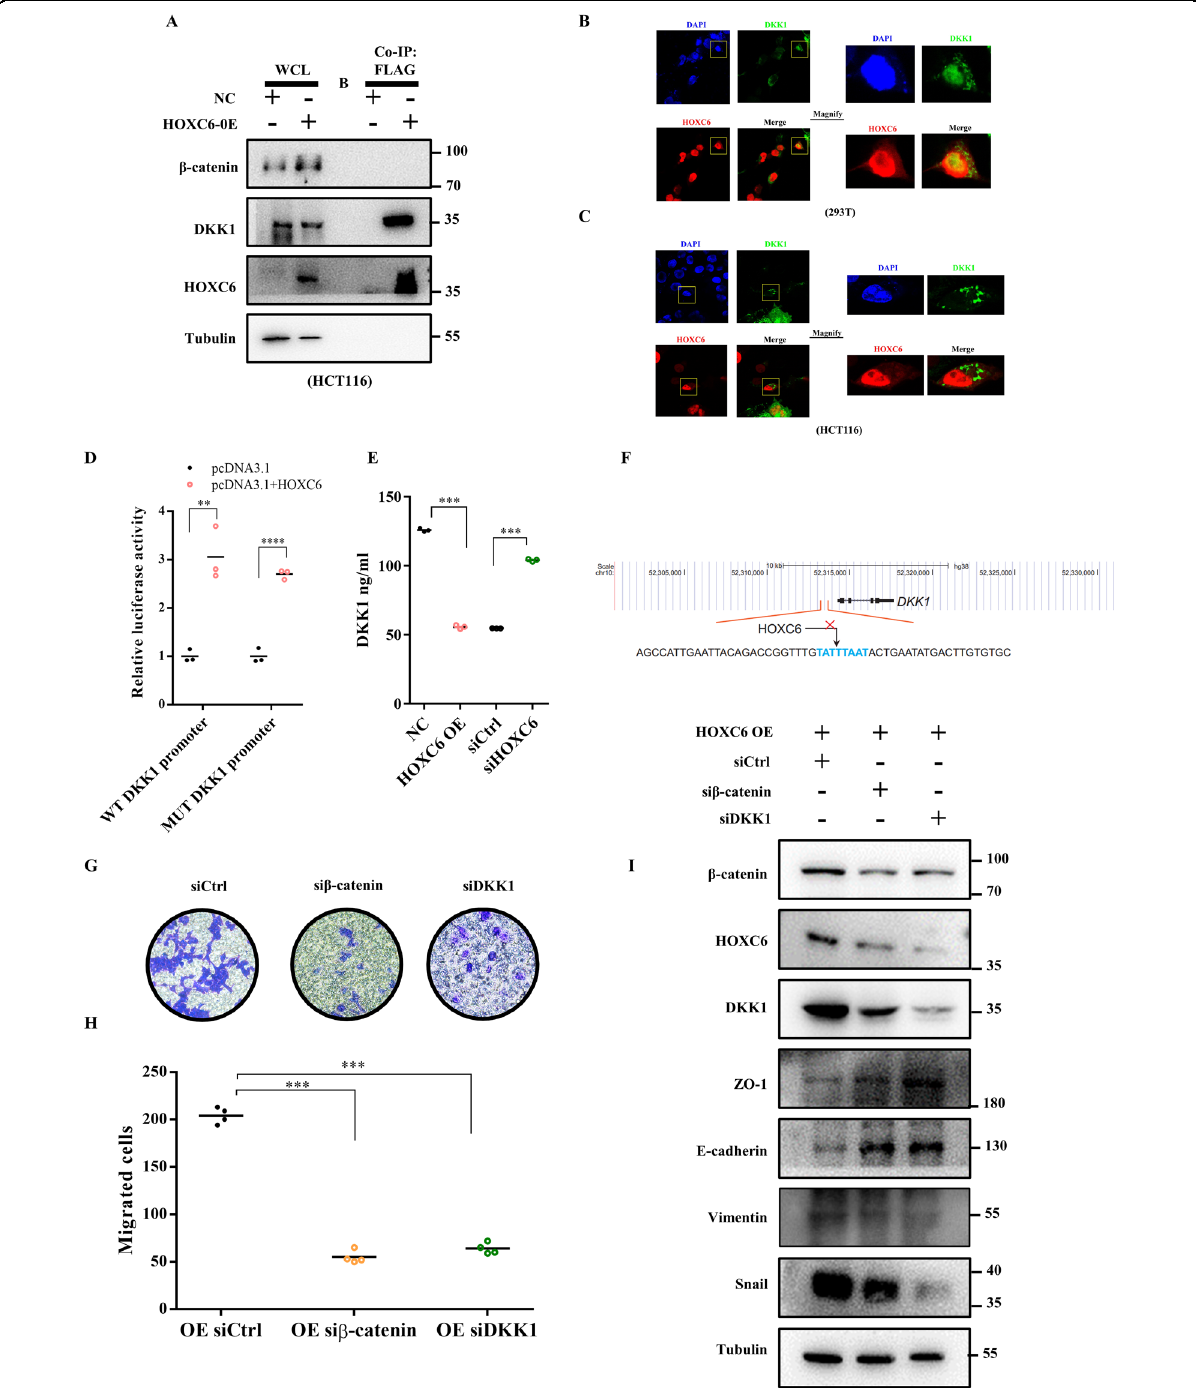
Fig. 5 HOXC6 activates Wnt/ β -catenin via inhibiting DKK1 excretion. A Co-IP using Flag-gel was performed with HCT116 cells in the HOXC6-OE and NC groups. Whole-cell lysate was loaded as a positive control. β -catenin, DKK1, and HOXC6 were evaluated in the Flag-HOXC6 complex. B HOXC6 and DKK1 fl uorescent colocalization in 293 T cells. C HOXC6 and DKK1 fl uorescent colocalization in HCT116 cells. D Dual luciferase assay testing the ability of HOXC6 to bind to the DKK1 promoter with WT and mutant sequences in HEK 293T cells. E ELISA detection of DKK1 concentration in cell supernatants in different HCT116 experimental groups. F Schematic diagram for the potential binding sequence of HOXC6in the DKK1 promoter. G Transwell experiment in the HOXC6-OE siCtrl, HOXC6-OE si β -catenin, and HOXC6-OE siDKK1 groups in HCT116 cells. H Numbers of migration HCT116 cells in the HOXC6-OE siCtrl, HOXC6-OE si β -catenin, and HOXC6-OE siDKK1 groups. I Expression of β -catenin, HOXC6, DKK1, ZO1, E- cadherin, Vimentin, and snail in HOXC6-OE siCtrl, HOXC6-OE si β -catenin, and HOXC6-OE siDKK1 groups in HCT116 cells. ***: P < 0.001.